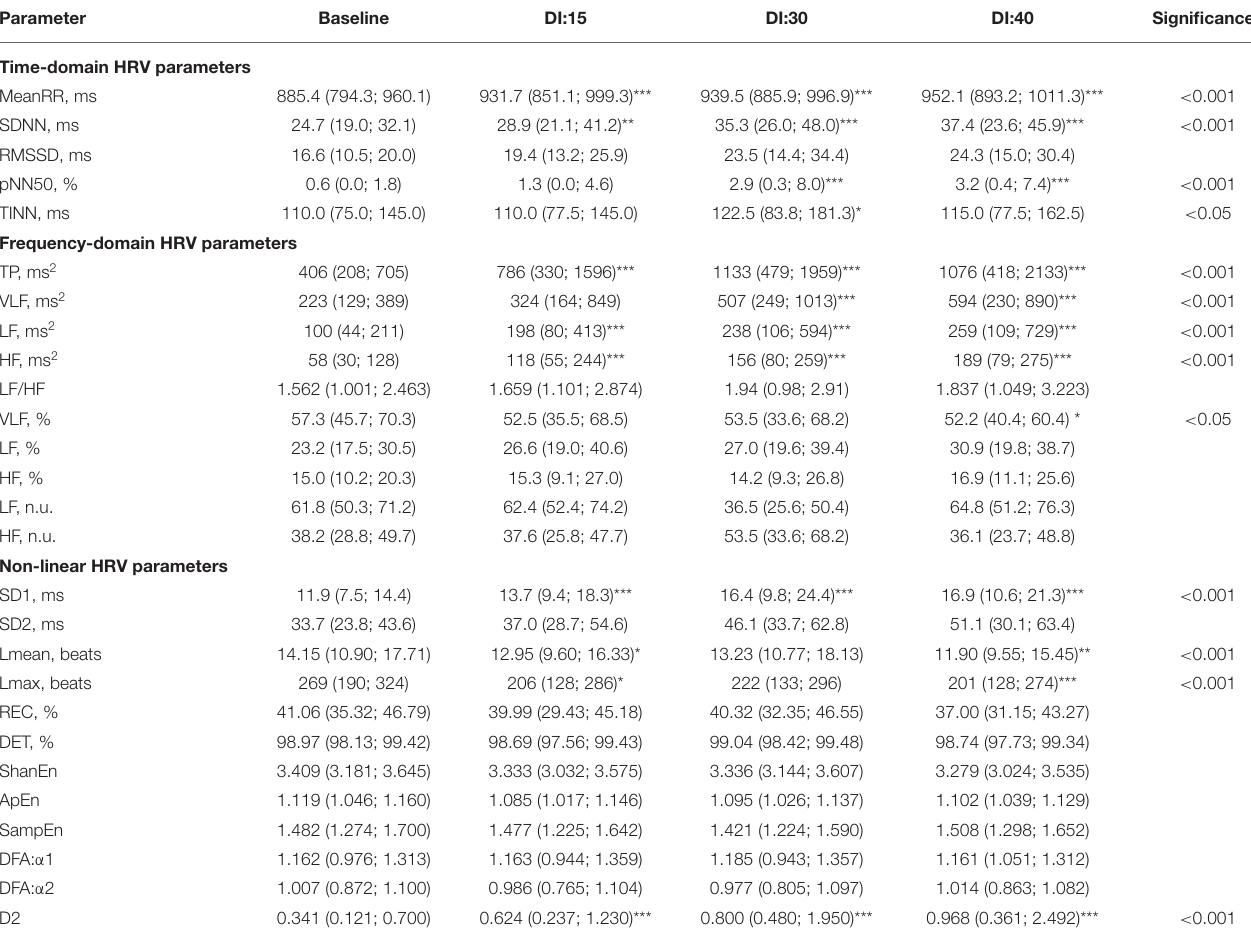
TABLE 2 | Heart rate variability parameters in PD subjects under short-term DI sessions (average of all studied DI sessions). Parameter Baseline DI:15 DI:30